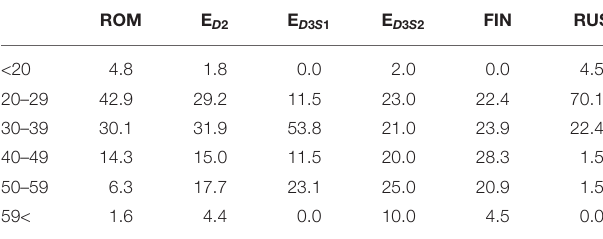
TABLE A2 | Percentage of participants in certain age ranges.